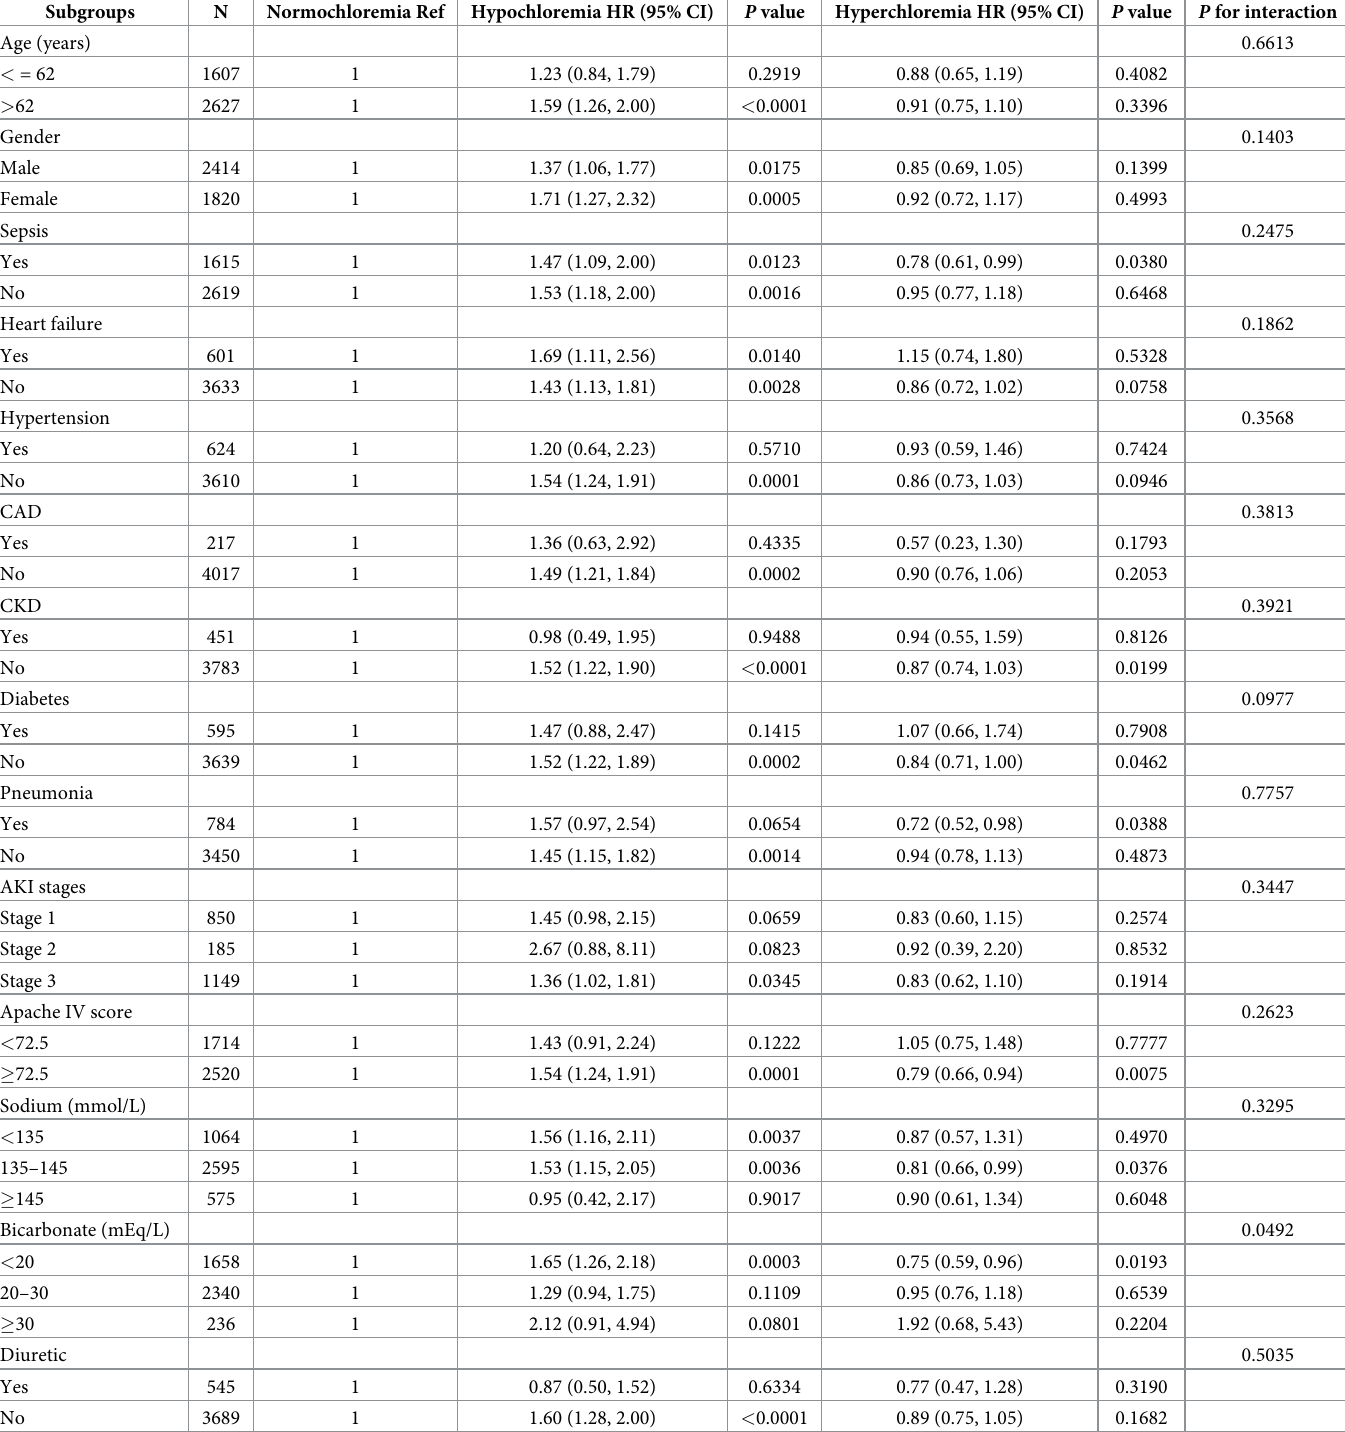
Table 3. Subgroup analysis for the effect of serum chloride on in-hospital mortality.